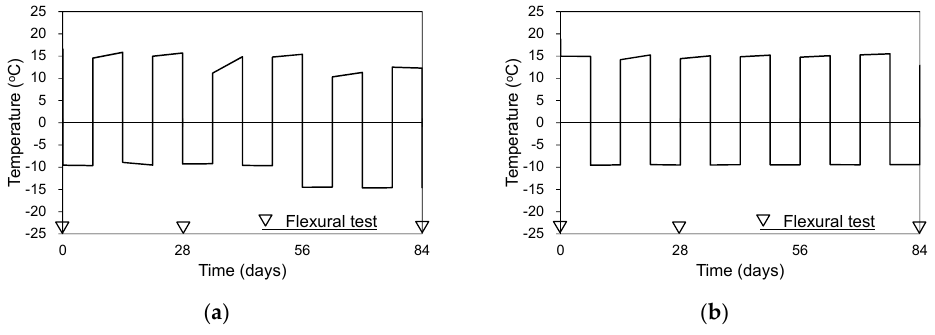
Figure 4. Temperature variation: ( a ) Beam B0; ( b ) Beams B10, B30 and B50.